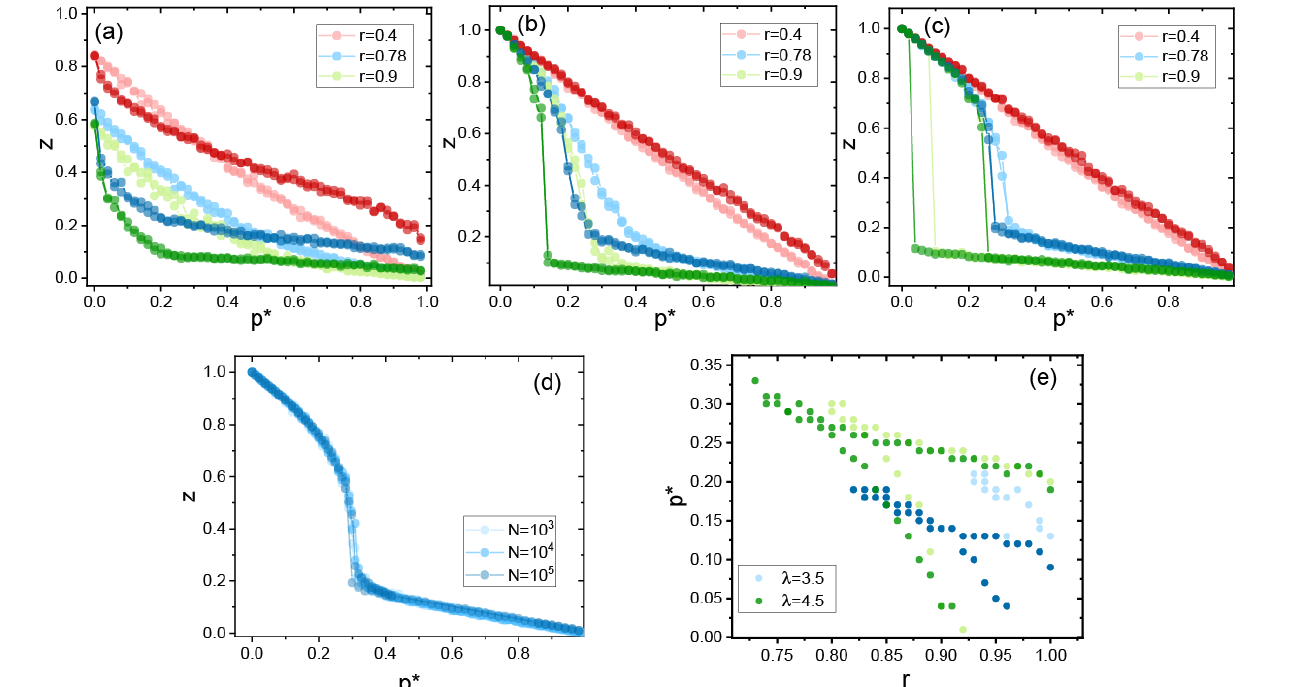
Figure 5. Phase diagrams of the SF network. ( a – c ) Simulation results of the average fraction of nodes for three different values of r , and the parameters are < k > = 10, m = 4, and N = 10 5 , and in proper order, λ = 2.5,3.5,4.5. ( d ) Simulation results of the average fraction of nodes for three different r values under LA for different N with λ = 4.5, < k > = 10, m = 4, and r = 0.78. ( e ) Jump points for different λ values. Dark and light symbols denote LA and RA, respectively. Simulation results have been averaged over 1000 network